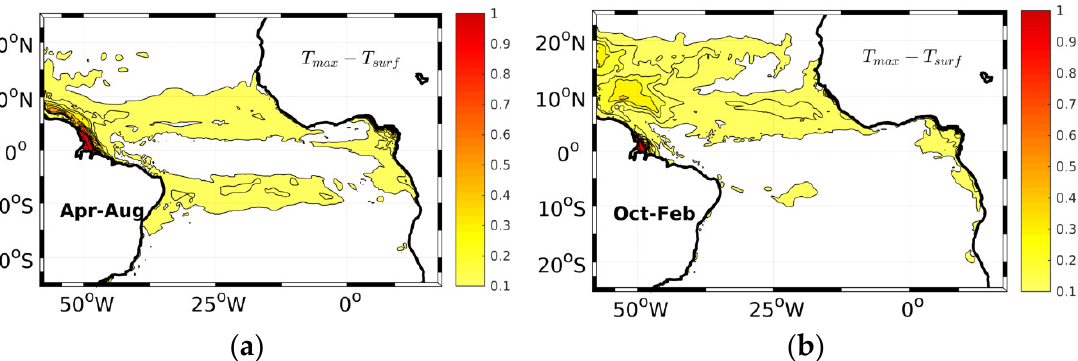
Figure 7. April-August ( a ) and October-February ( b ) average of a temperature inversion. Units are in C.